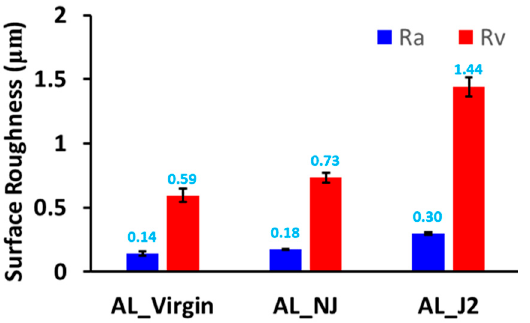
Figure 13. Surface roughness ( 𝑅 (cid:3028) and 𝑅 (cid:3049) ) of specimens with no jet and with a secondary jet.